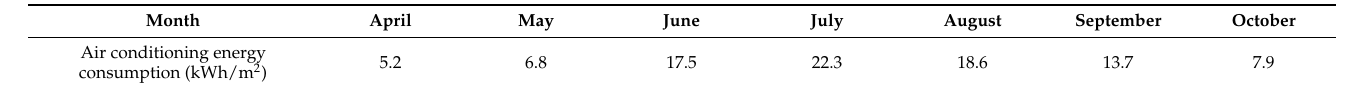
Table 6. Power density of personnel, lighting and equipment in main functional